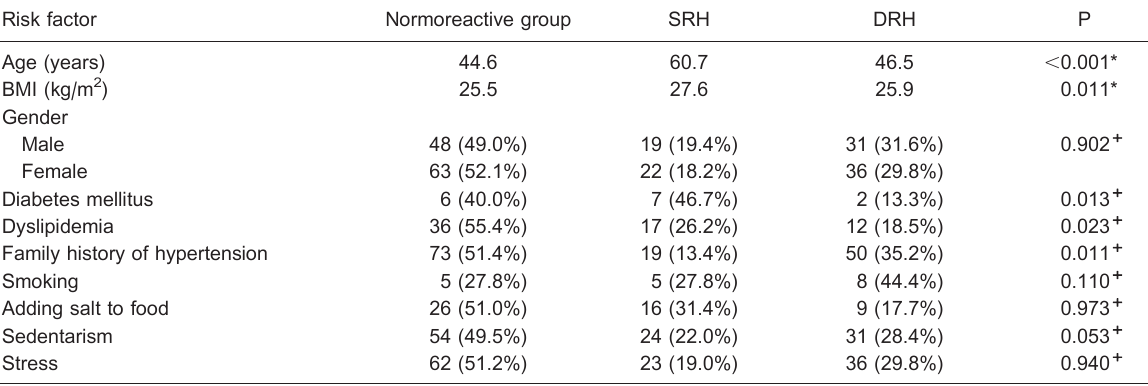
Table 3. Prevalence of risk factors for hypertension in normoreactive and hyperreactive